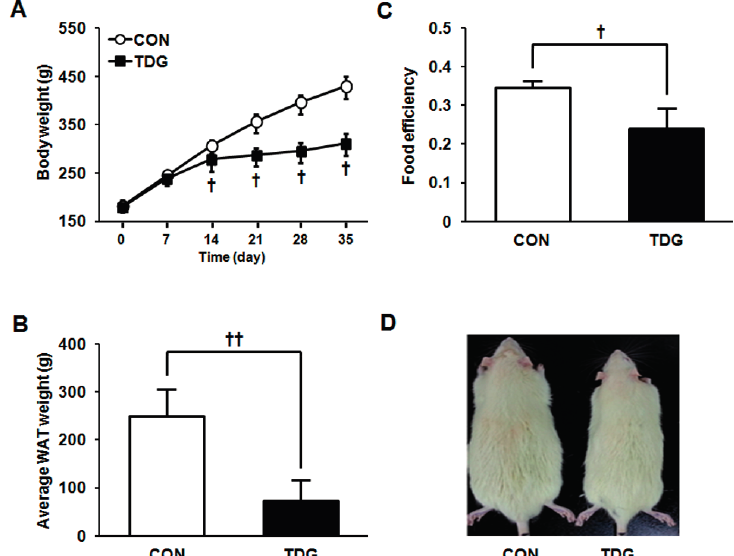
Figure 1. Time profiles of body weight gain ( A ) average white adipose tissue (WAT) weight ( B ) and food efficiency ( C ) between control and thiodigalactoside (TDG)-treated rats; ( D ) Image of control and TDG-treated rats. Statistical significance between control and TDG-treated groups was calculated by Student’s t- test, where p -values are † p < 0.05 and †† p <